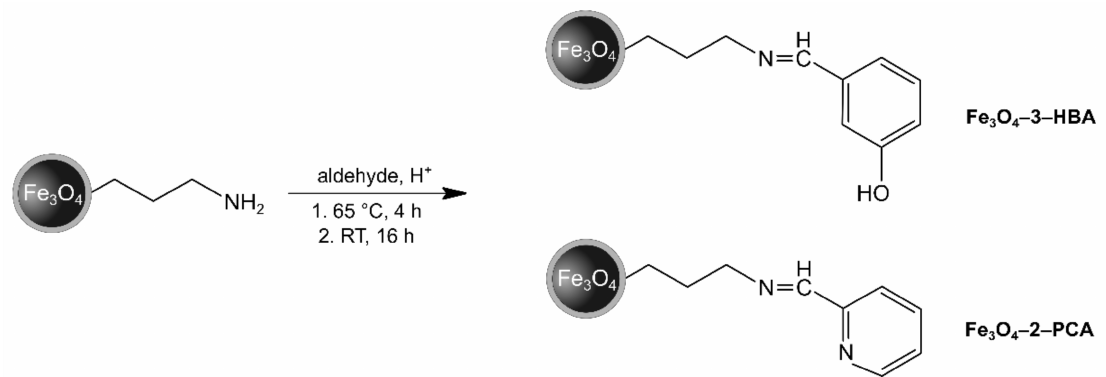
Figure 1. Synthesis of the Schiff base-functionalized materials.